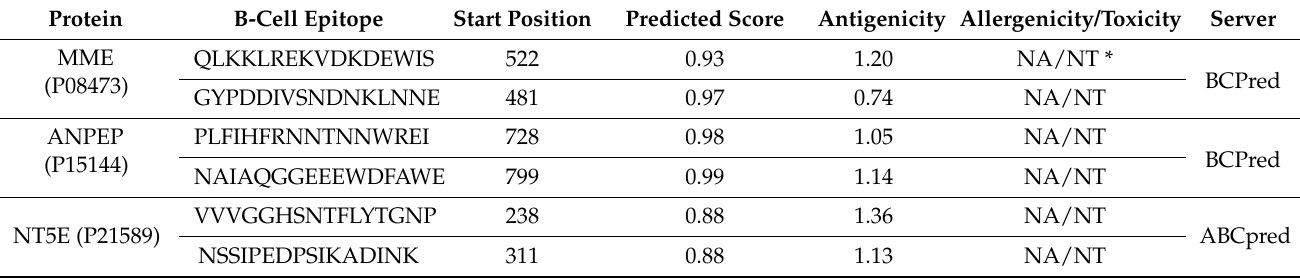
Table 4. List of B-cell epitopes selected for design of vaccine